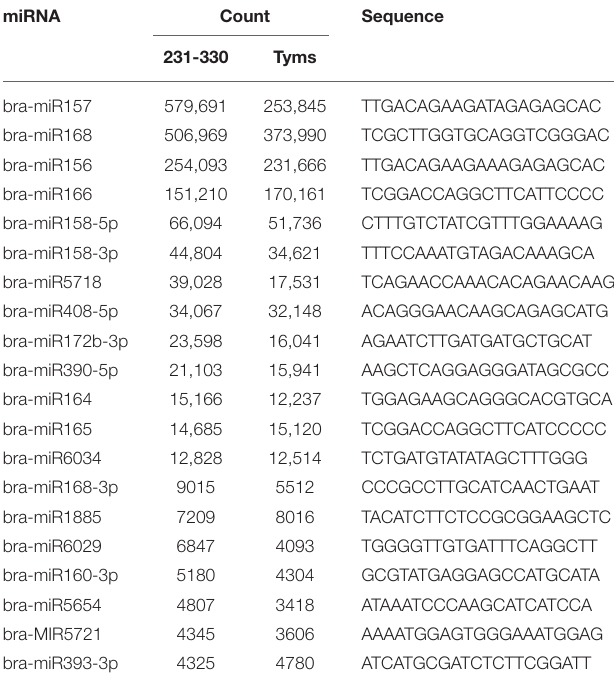
TABLE 1 | The most highly expressed known miRNAs.